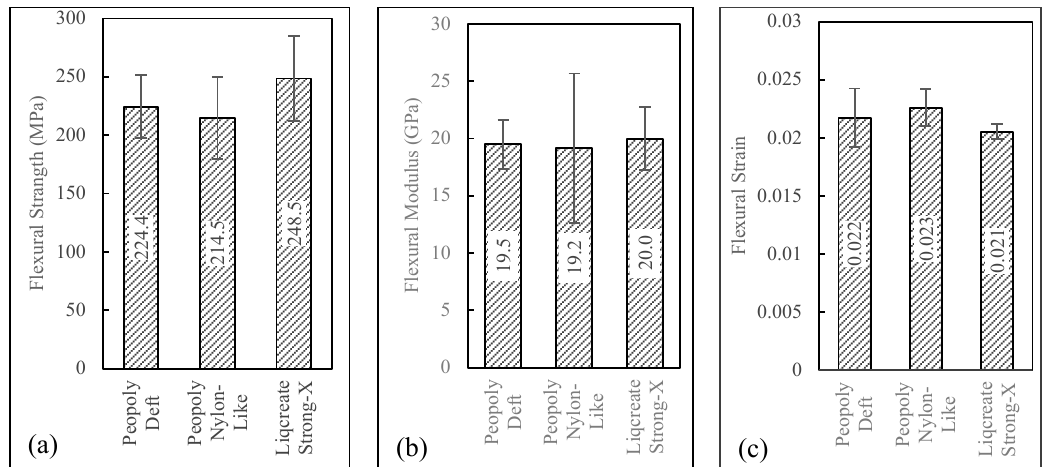
Figure 13. ( a ) Flexural strength, ( b ) flexural modulus, and ( c ) flexural strain.